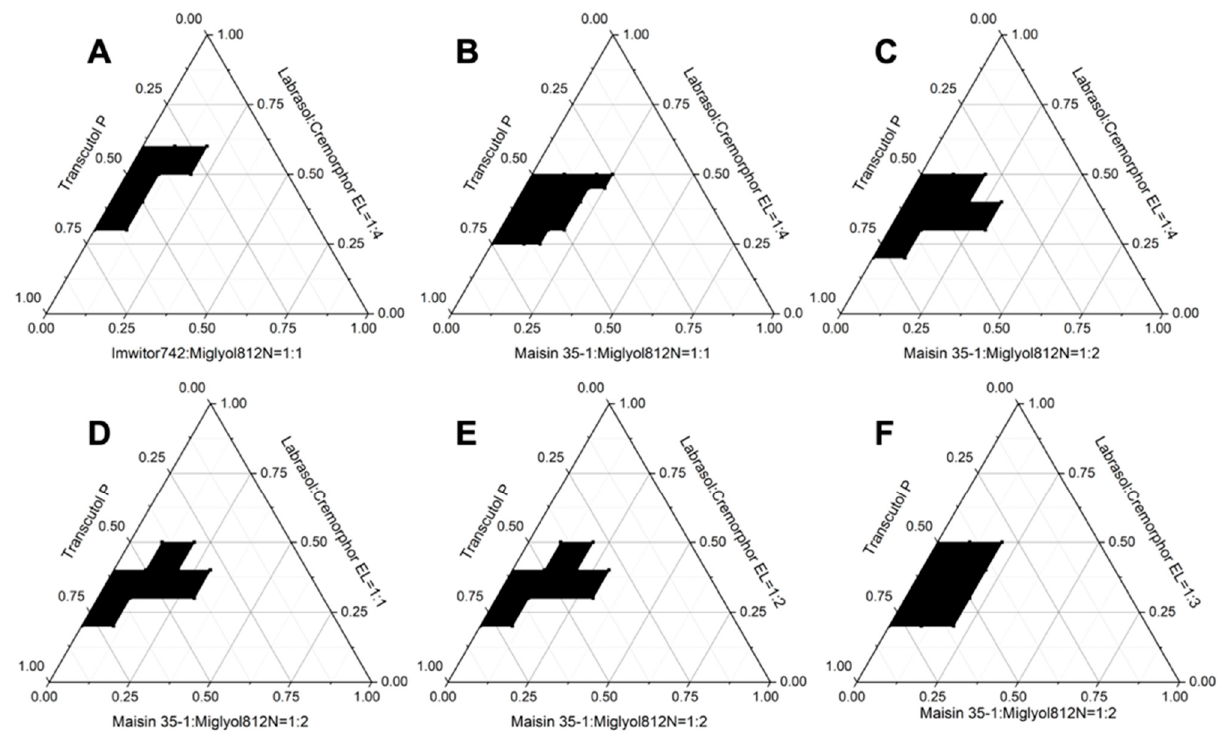
Figure 4. Pseudo‑ternary phase diagrams of different compositions of oil, surfactant, and co‑ surfactant. The region of self‑microemulsifaction is in black. ( A , B ) indicates effects of different oil on the efficient self‑microemulsifacation. The oil phase was as follows: ( A ) as Imwitor742:Miglyol 812N = 1:1; ( B ) as Maisin 35‑1:Miglyol 812N = 1:1. ( C – F ) indicates effects of different ratios between Labrasol and Cremophor EL from 1:1 to 1:4 on the efficient self‑microemulsifacation,